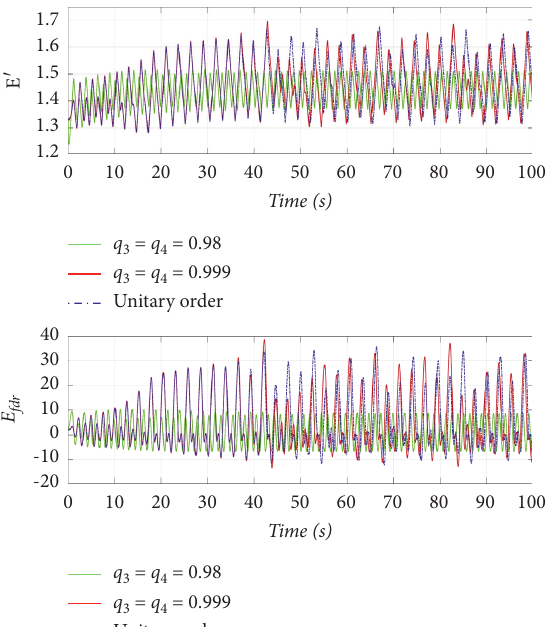
� q � 1 and different values for q 1 2